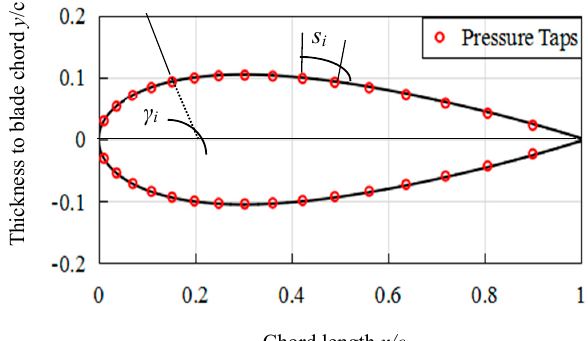
Figure 9. Distribution of pressure taps on blade surface.